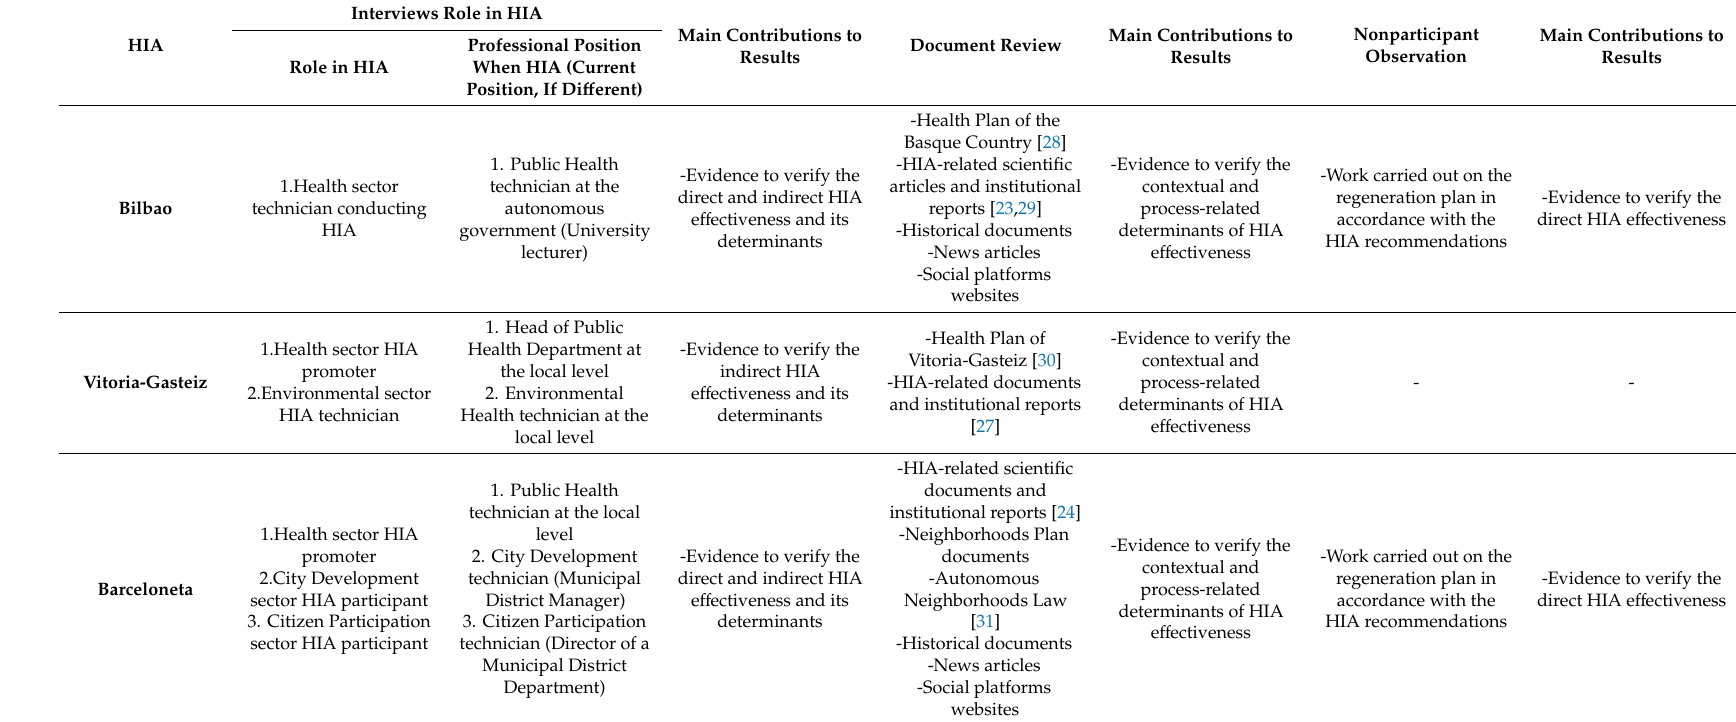
Table 3. Methods and main contributions to